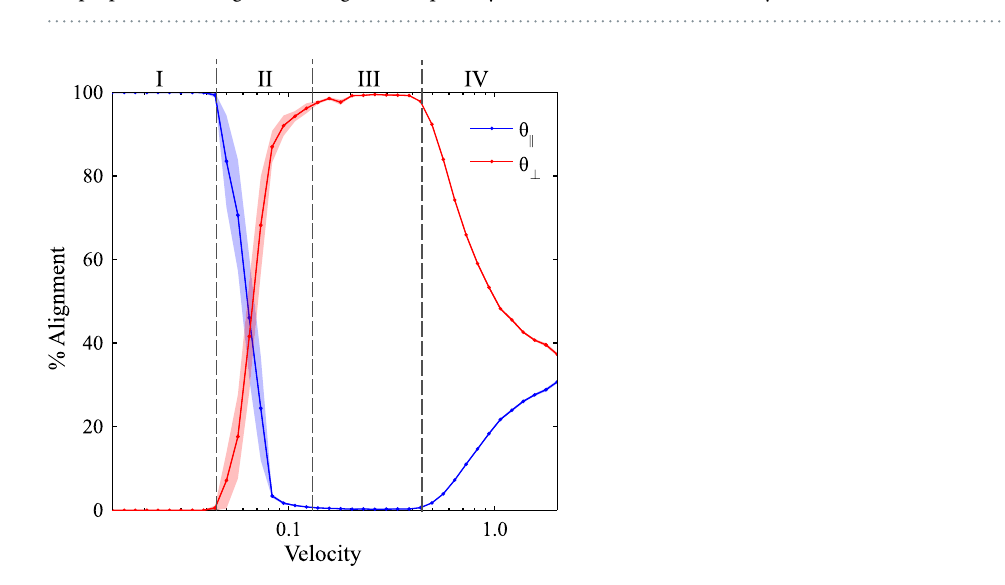
Figure 6. Same as Fig. 3 with a zone velocity of v zone = 0.6366. Although the system contains some preference for perpendicular alignment, a significant quantity of defects exists at this velocity.